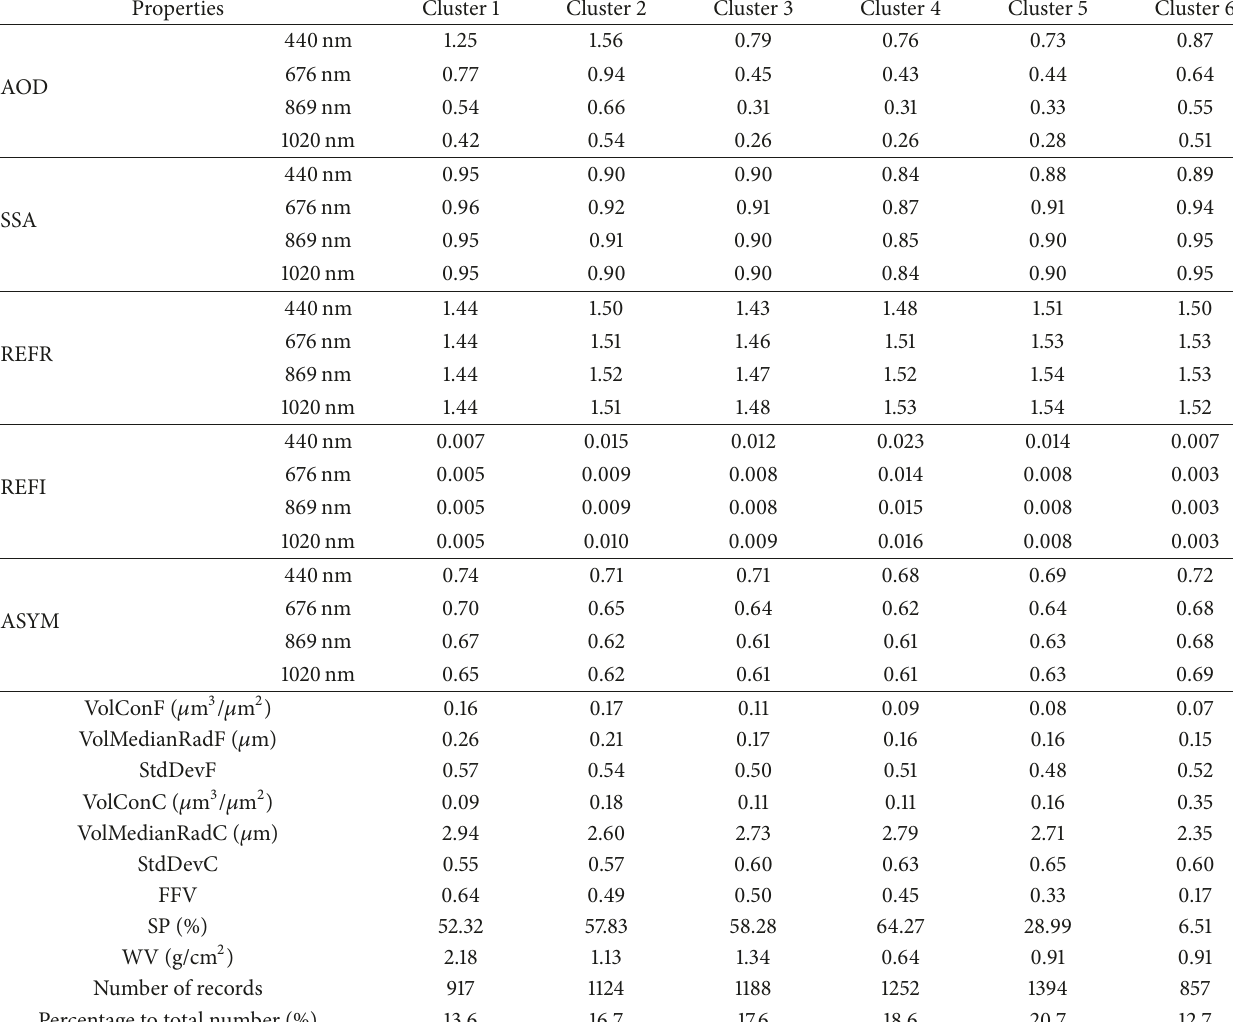
Table 2: Results of the fuzzy cluster